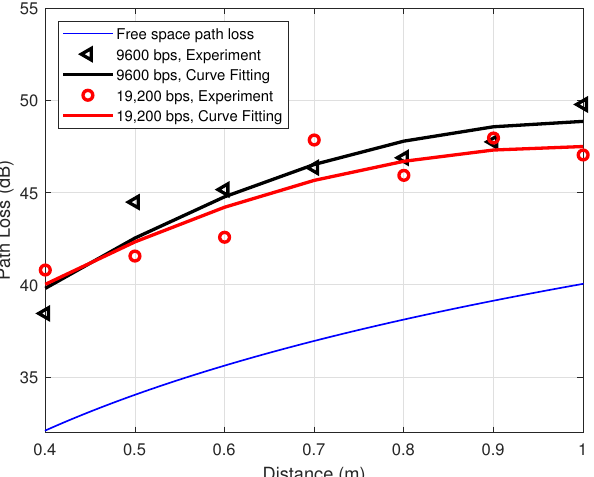
Figure 6. On-ankle path loss for different data rates at the transmitted power P 0 = 0 dBm.